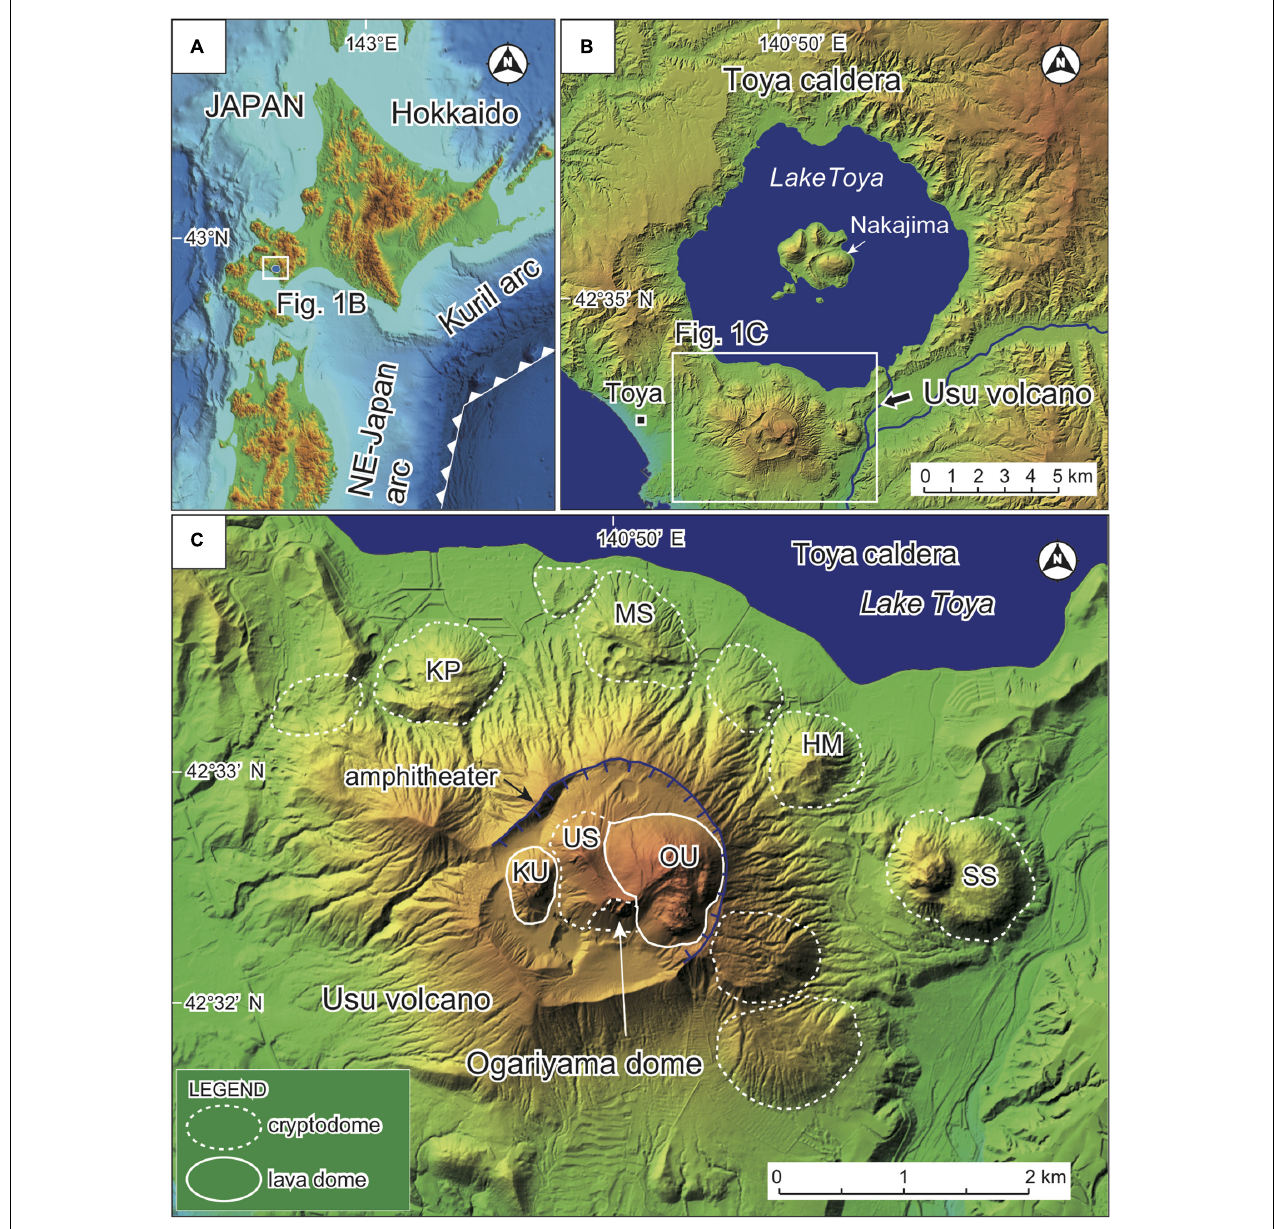
FIGURE 1 | (A) Tectonic setting of Usu volcano in southwestern Hokkaido, Japan. The volcano is located at the junction between the Kuril and NE Japan arcs. (B) Location of Usu volcano, which is a post-caldera volcano of Toya caldera. (C) Topographic map of Usu volcano, showing the location of the Ogariyama dome. Usu volcano comprises a basaltic to andesitic stratovolcano with an amphitheater at its summit, and contains many silicic cryptodomes and lava domes, including Kompira-yama (KP), Meiji-Shinzan (MS), Higashi-Maruyama (HM), Showa-Shinzan (SS), Ko-Usu (KU), Usu-Shinzan (US), O-Usu (OU), and Ogariyama. The base maps were produced by topographic data issued by the Geospatial Information Authority of